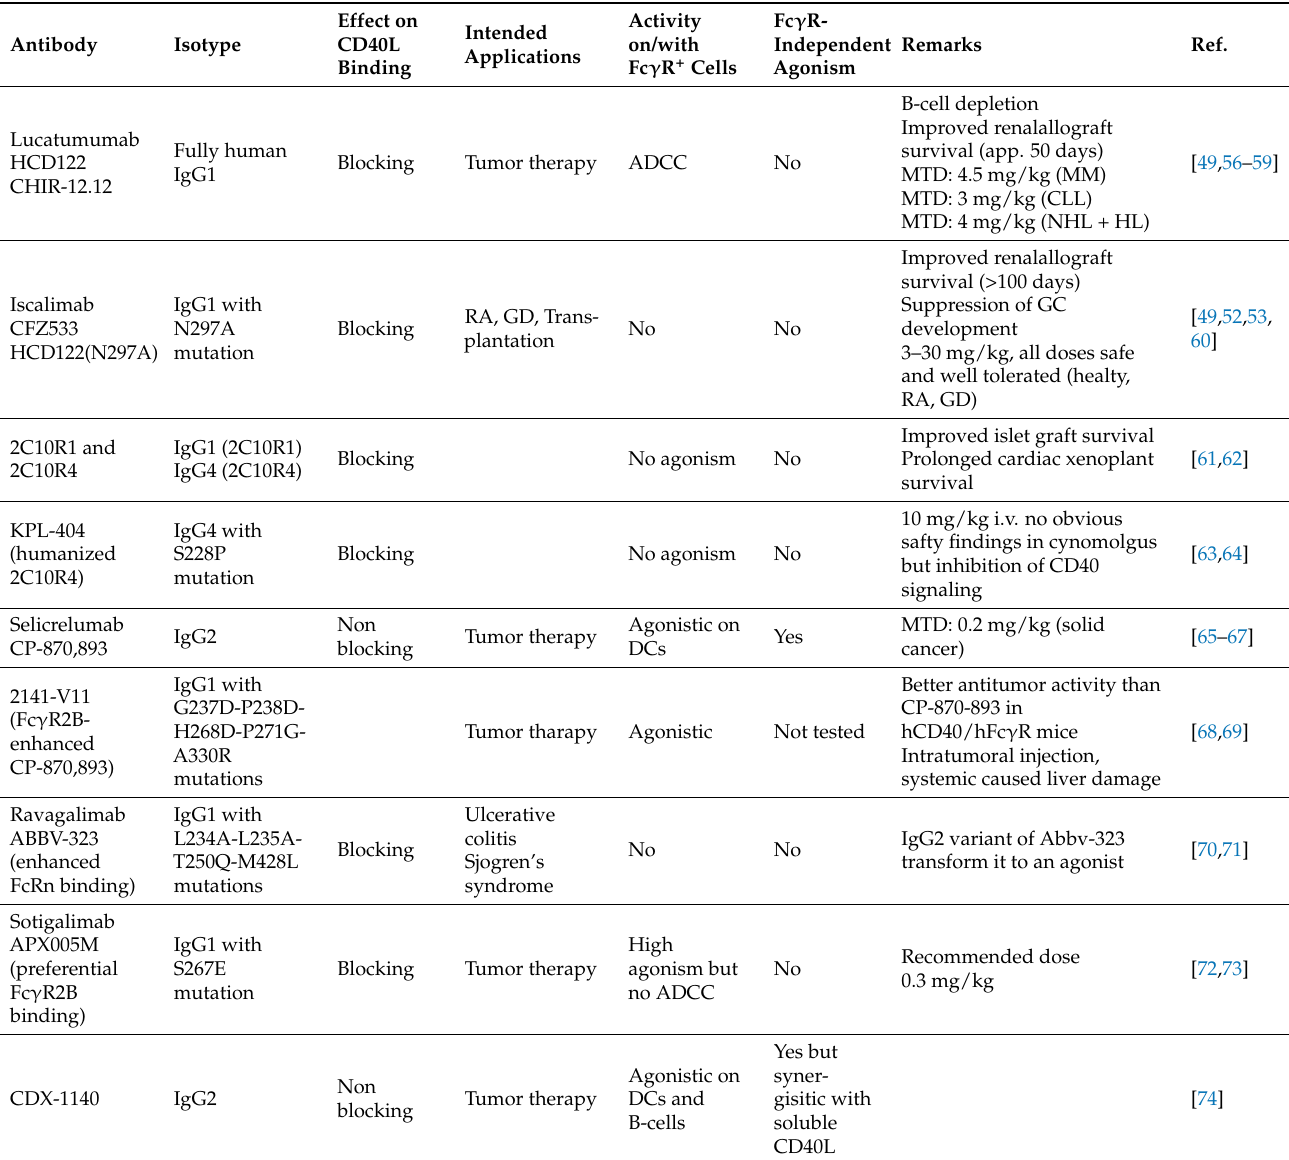
Table 1. Characteristics of prominent preclinical and clinical anti-CD40 antibodies. MTD, maximum tolerable dose; DLT, dose-limiting toxicity; GD, Graves disease; MM, multiple myeloma; CLL, chronic lymphocytic leukemia; NHL, non Hodgkin lymphoma; RA, rheumatoid